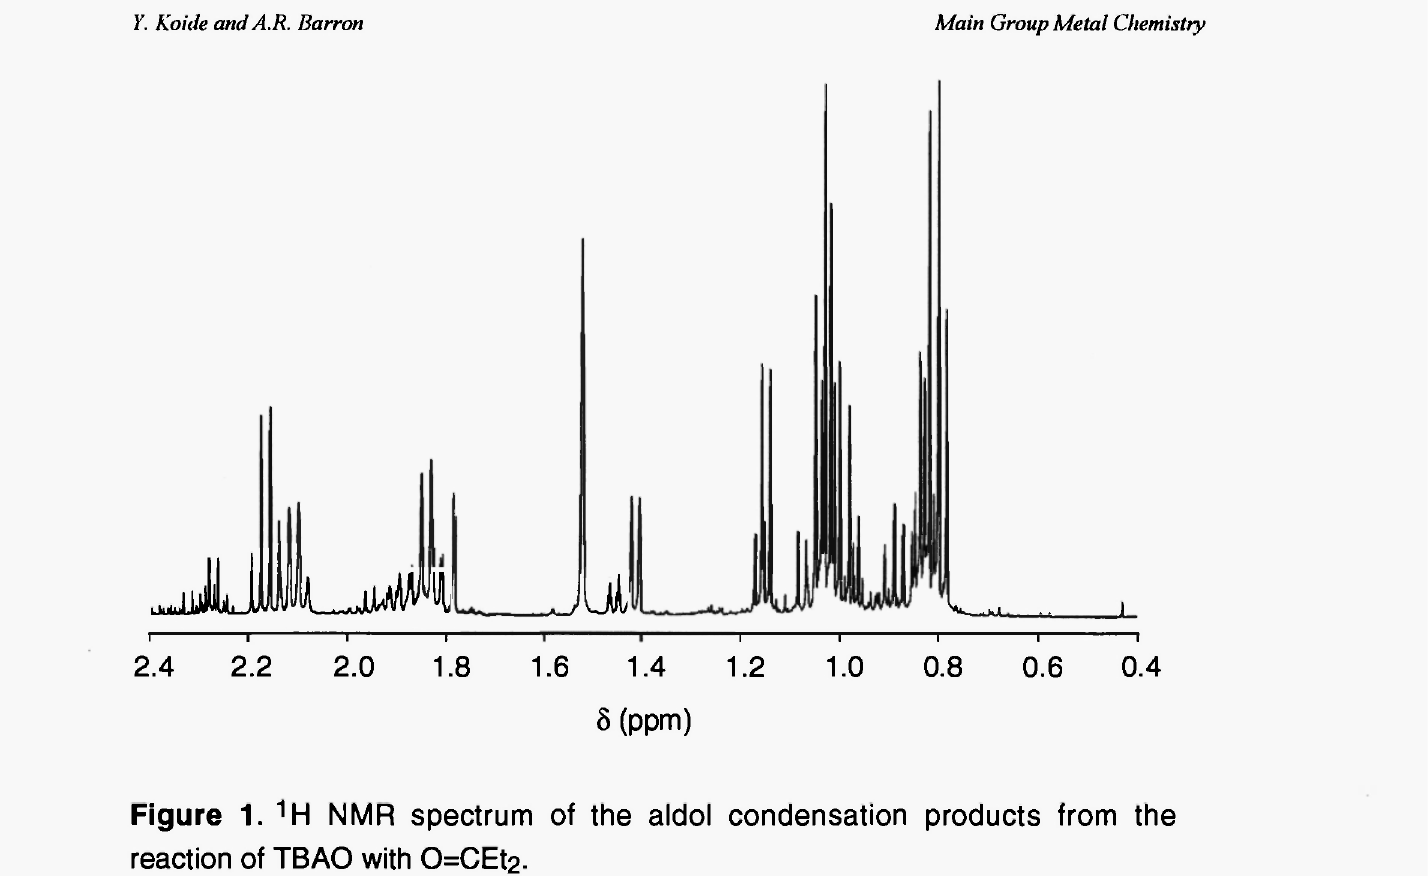
Figure 1. 1 H NMR spectrum of the aldol condensation products from the reaction of TBAO with 0=CEt 2